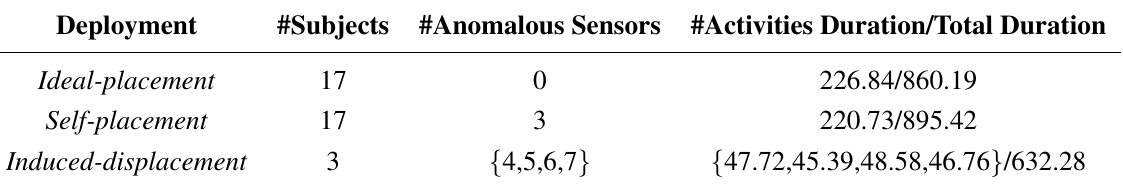
Table 2. Dataset description summary. The overall cumulative duration for the complete set of activities with respect to all of the collected data is given in